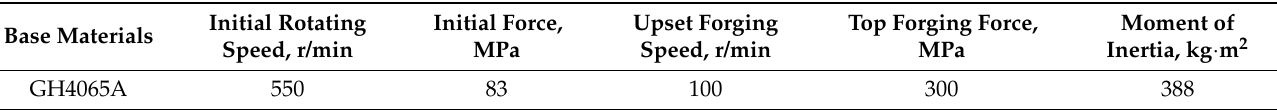
Table 2. GH4065A alloy IFW welding process parameters.